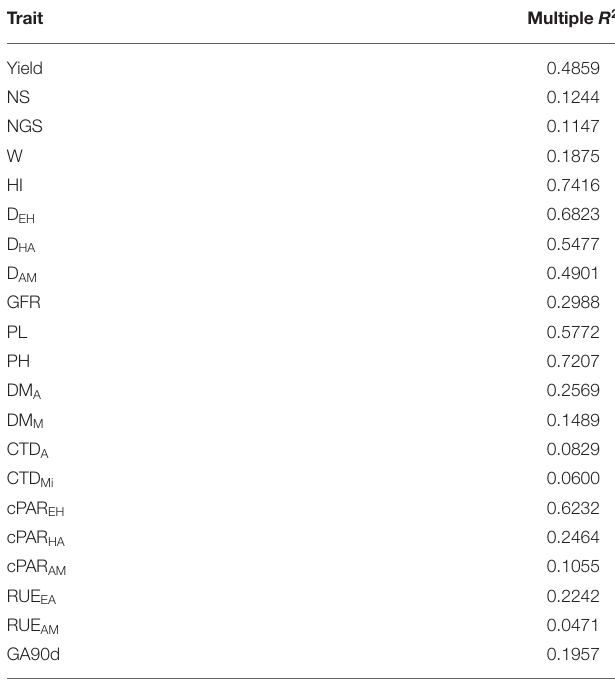
TABLE 2 | Multiple linear regression ( R 2 ) estimation of the impact of genetic population structure on the phenotypic